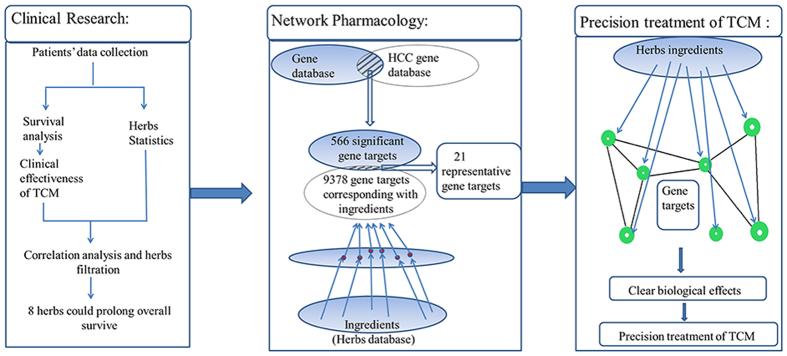
Process overview.